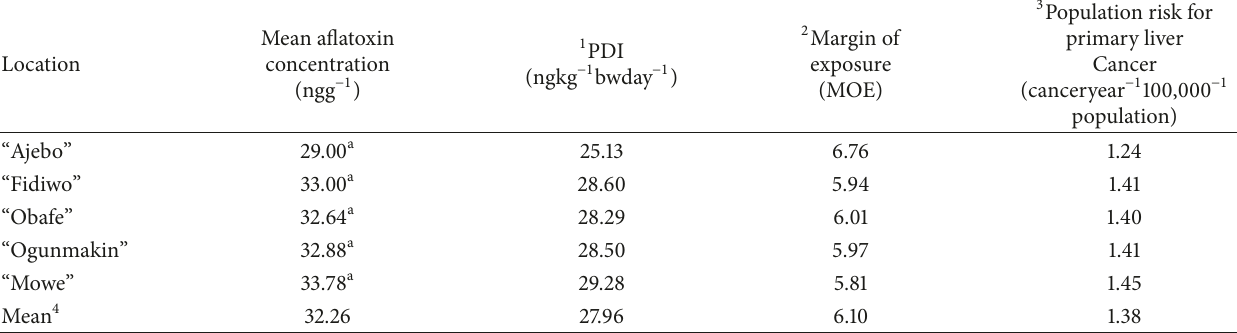
Table 7: Risk Assessment due to consumption of groundnuts from Obafemi Owode Local Government Area, Ogun State, Nigeria.